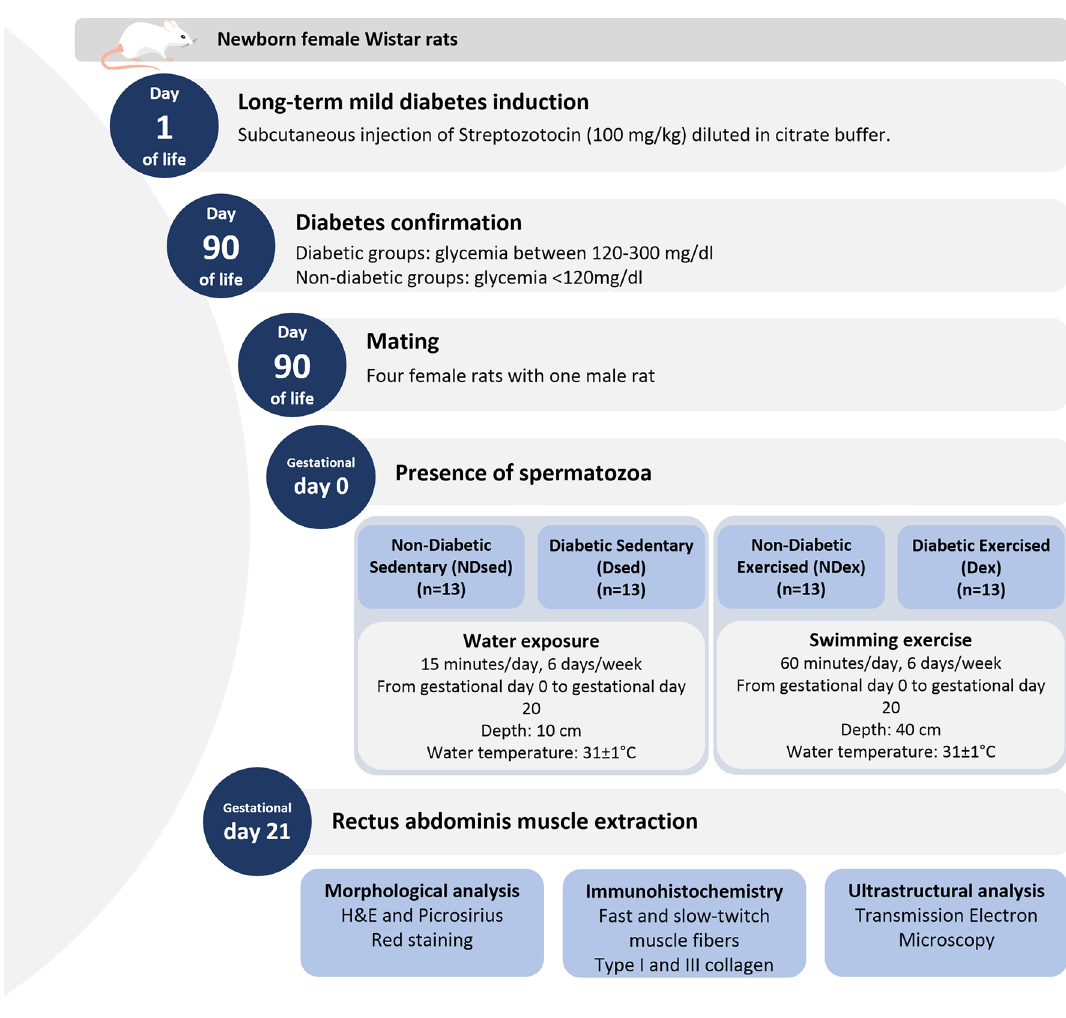
Figure 5. Experimental sequence of